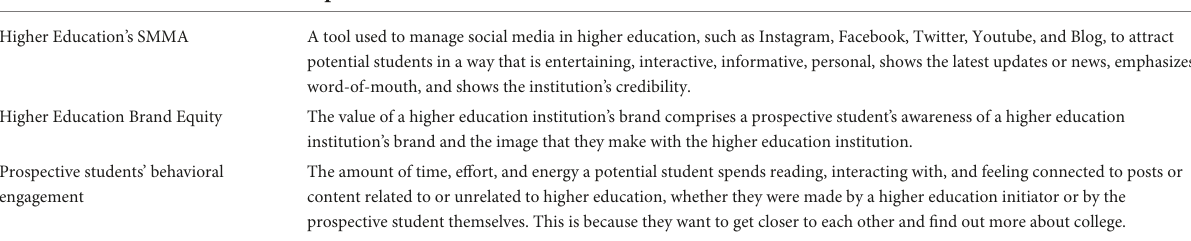
TABLE 2 Operational